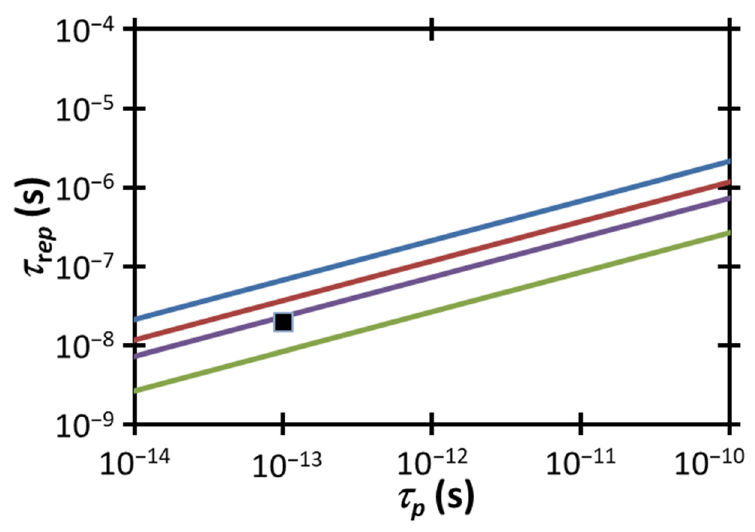
Figure 6. Average power density (cid:104) w (cid:105) to achieve ∇ T ep , the estimated temperature gradient necessary for direct electropermeabilization, as a function of pulse duration τ p and time between pulses τ rep . Regions above the curves, indicating a sufficiently long time between subsequent pulses, represent ∇ T > ∇ T ep for the given (cid:104) w (cid:105) . The black square represents the experimental condition of 1550 nm, τ rep = 20 ns, t p = 100 fs, and 6.6 × 10 6 W cm − 3 < (cid:104) w (cid:105) < 1.1 × 10 7 W cm − 3 . Satisfying the electropermeabilization threshold for the current experimental τ p and τ rep would require increasing (cid:104) w (cid:105) to 1.6 × 10 7 W cm − 3